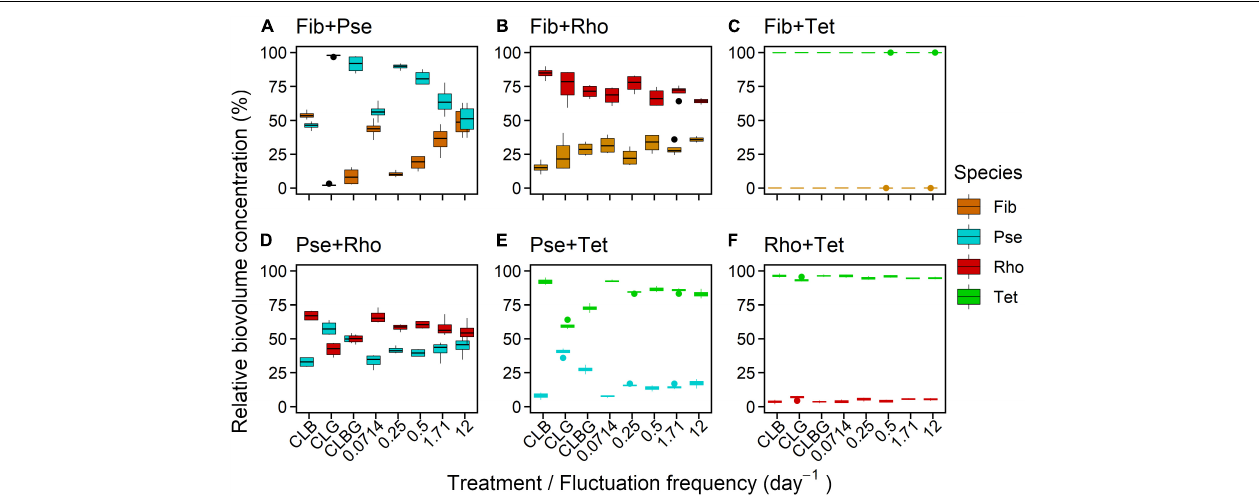
FIGURE 8 | Species-specific contribution to total biovolume (%) under constant and fluctuating conditions for two-species mixtures (A–F) after the experiment (16 days). Colors indicate the species in combination. The distance of both species’ biovolumes indicates the extent of domination. Values of 100 and 0%, respectively, indicate exclusion. Positions on the x -axis were slightly shifted for better visibility.